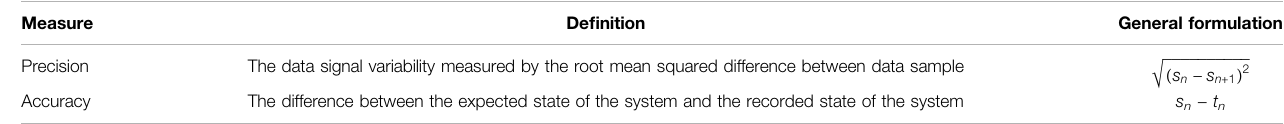
TABLE 1 | Validation de fi nitions. Measure De fi nition General formulation Precision